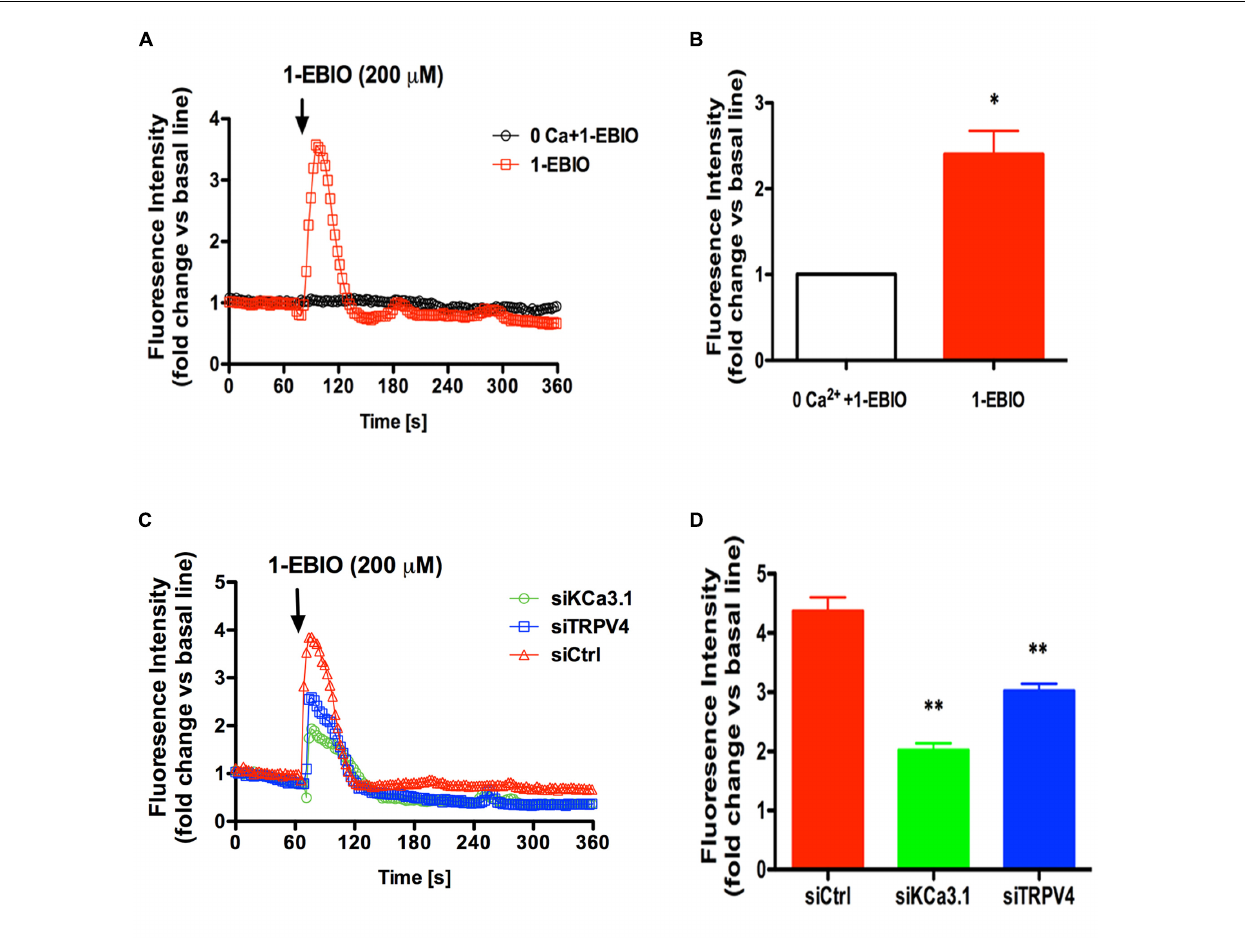
FIGURE 6 | TRPV4 involved in Ca 2 + entry induced by KCa3.1 activation in asthmatic HBSM cells. (A,C) Representative curves showed the fold changes in [Ca 2 + ] i relative to the unstimulated condition over 360 s. (B,D) The bar graphs indicated the maximal increase in [Ca 2 + ] i mobilization. (A) External calcium was required for 200 µ M 1-EBIO-induced Ca 2 + elevations. The increase of [Ca 2 + ] i induced by 200 µ M 1-EBIO was prevented by 0 external Ca 2 + . (B) Quantitative analysis of 1-EBIO-induced Ca 2 + entry. n = 10–20, ∗ p < 0.05, unpaired, two-tailed Student’s t -test compared with 0 Ca 2 + + 1-EBIO. (C) Representative traces of 1-EBIO-induced Ca 2 + entry in. 1-EBIO was used at 200 µ M. (D) Quantitative analysis of 1-EBIO-induced Ca 2 + entry. The increase of [Ca 2 + ] i induced by KCa3.1 activation was drastically reduced by siKCa3.1 and siTRPV4. n = 10–20, ∗ p < 0.05, ∗∗ p < 0.01, one-way ANOVA followed by the Dunnett’s multiple comparison test compared with siCtrl. Ctrl,